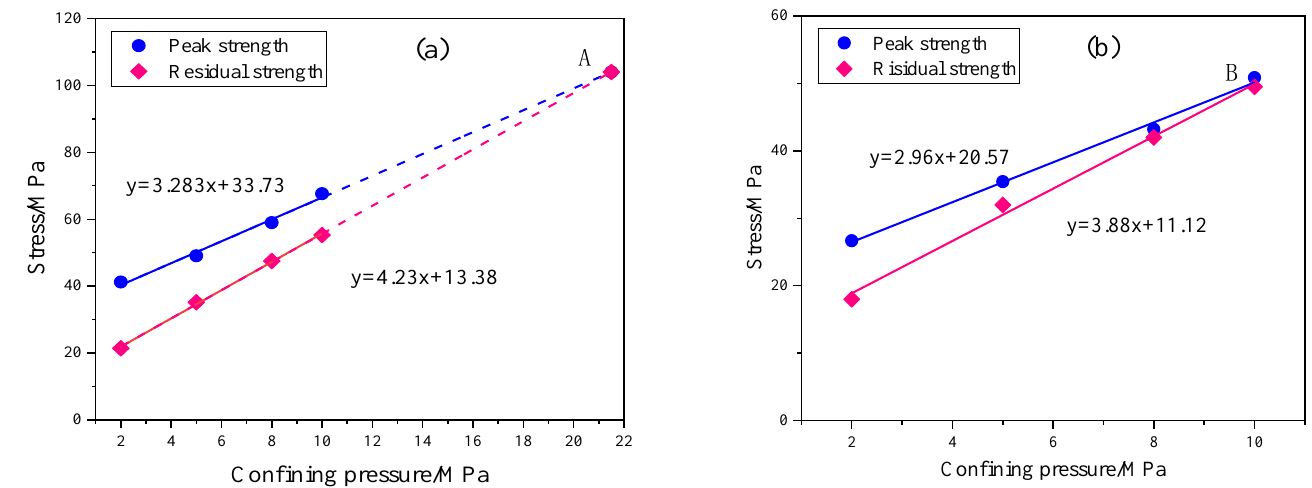
Figure 14. Strength analysis of ( a ) black sample and ( b ) white sample .